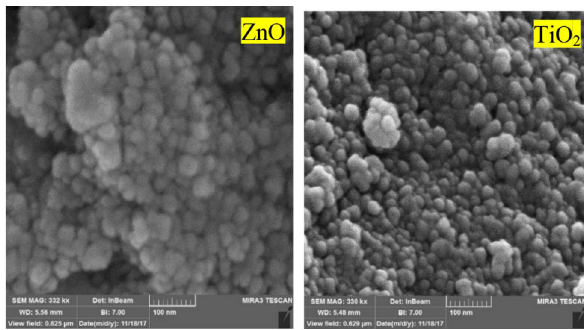
Figure 2. FE-SEM of TiO 2 quantum dots and ZnO quantum dots.